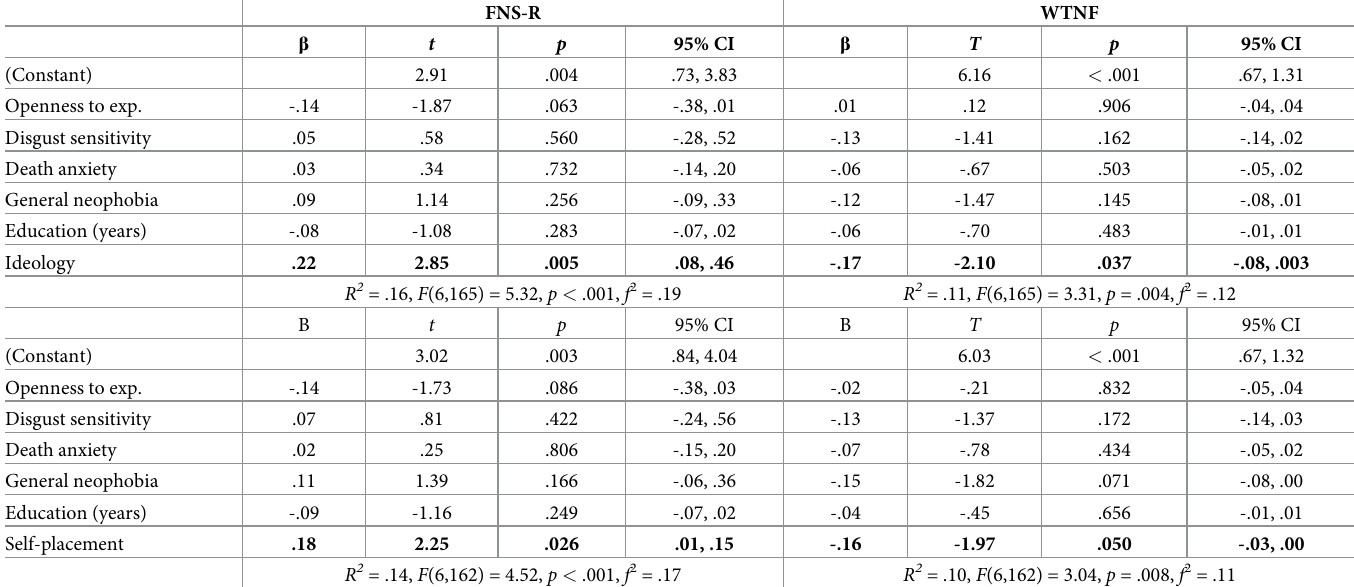
Table 2. Results of linear regression on participants’ food neophobia (both FNS-R and WTNF scores) predicted by socio-political ideology and left-right self-place- ment, as well as common antecedents (Study 1).